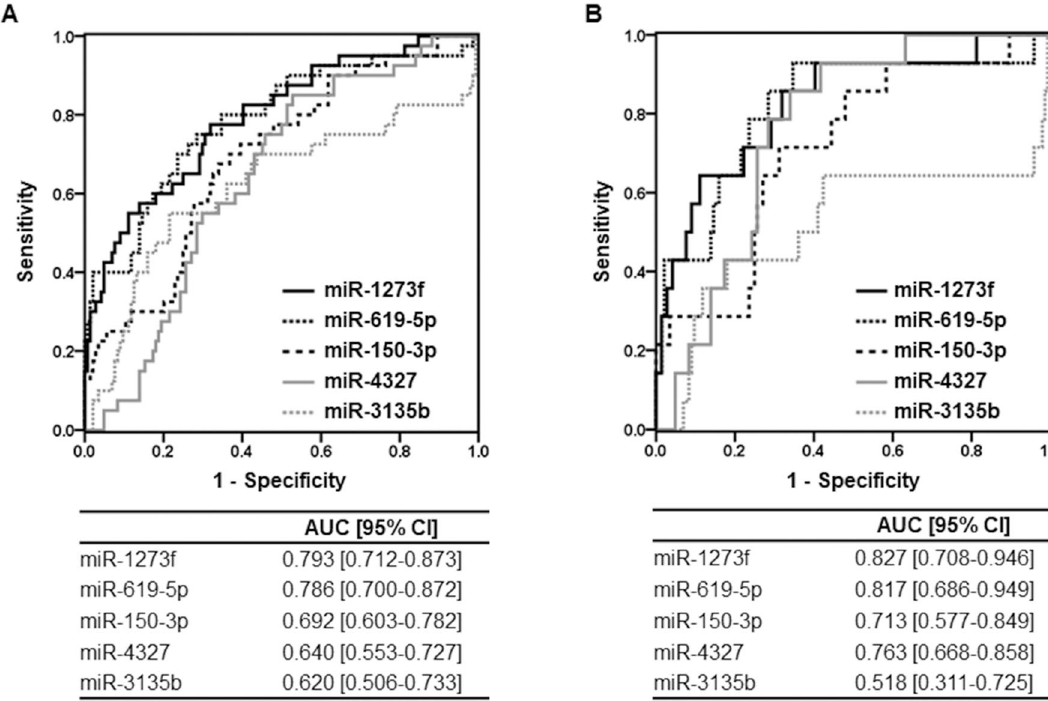
Figure 2. Receiver operating characteristic curves in the training/test cohort. ( A ) HC vs. all stage ESCC, ( B ) HC vs. stage I ESCC. Receiver operating characteristic curves were obtained from five urinary miRNAs. AUC area under the curve; 95% CI 95% confidence